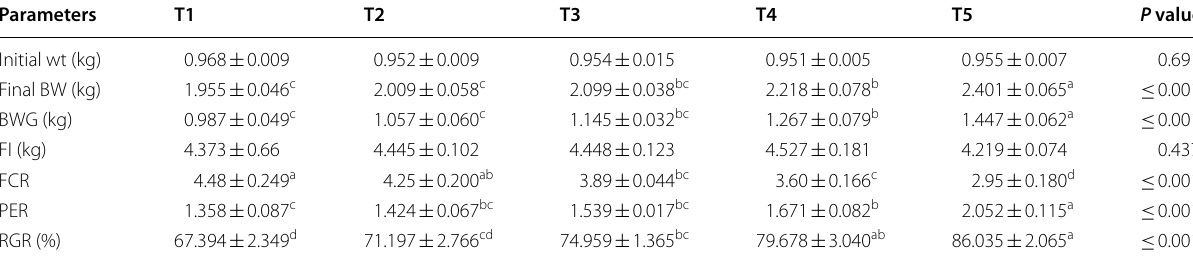
T1, basal diet with no additives; T2, basal diet supplemented with citric acid (10 g/kg) and no whey; T3, T2 T5, T2 whey powder (22.5 g/kg) + BW body weight; BWG body weight gain; FI feed intake; FCR feed conversion ratio; PER protein efficiency ratio; RGR relative growth rate a–d Means within the same row carrying different superscripts are significantly different at (P Table 3 The effect of graded levels of whey with addition of citric acid on carcass traits % relative to life body weight